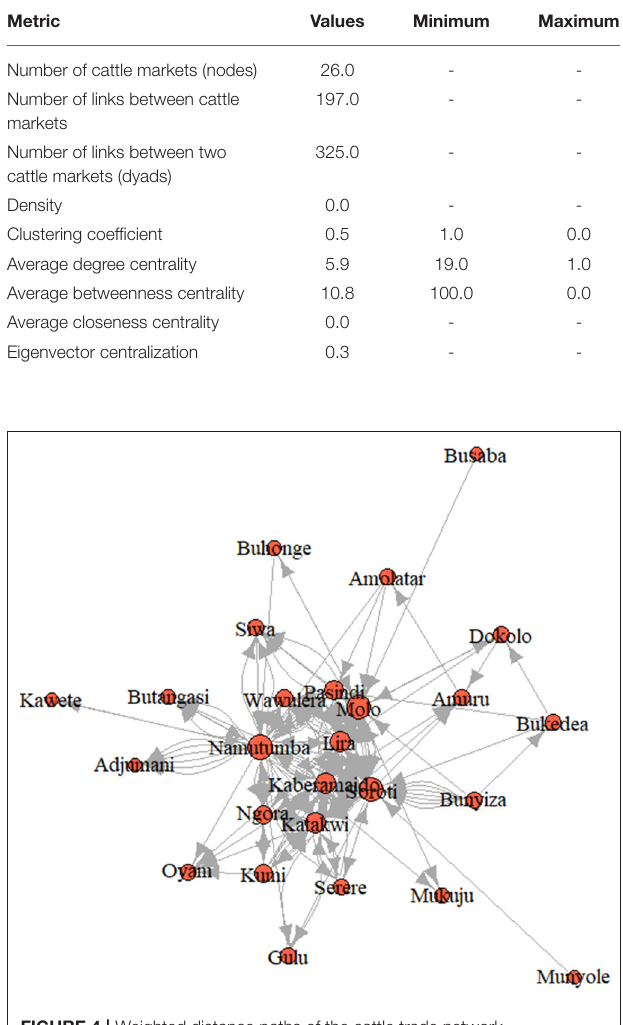
FIGURE 4 | Weighted distance paths of the cattle trade network.